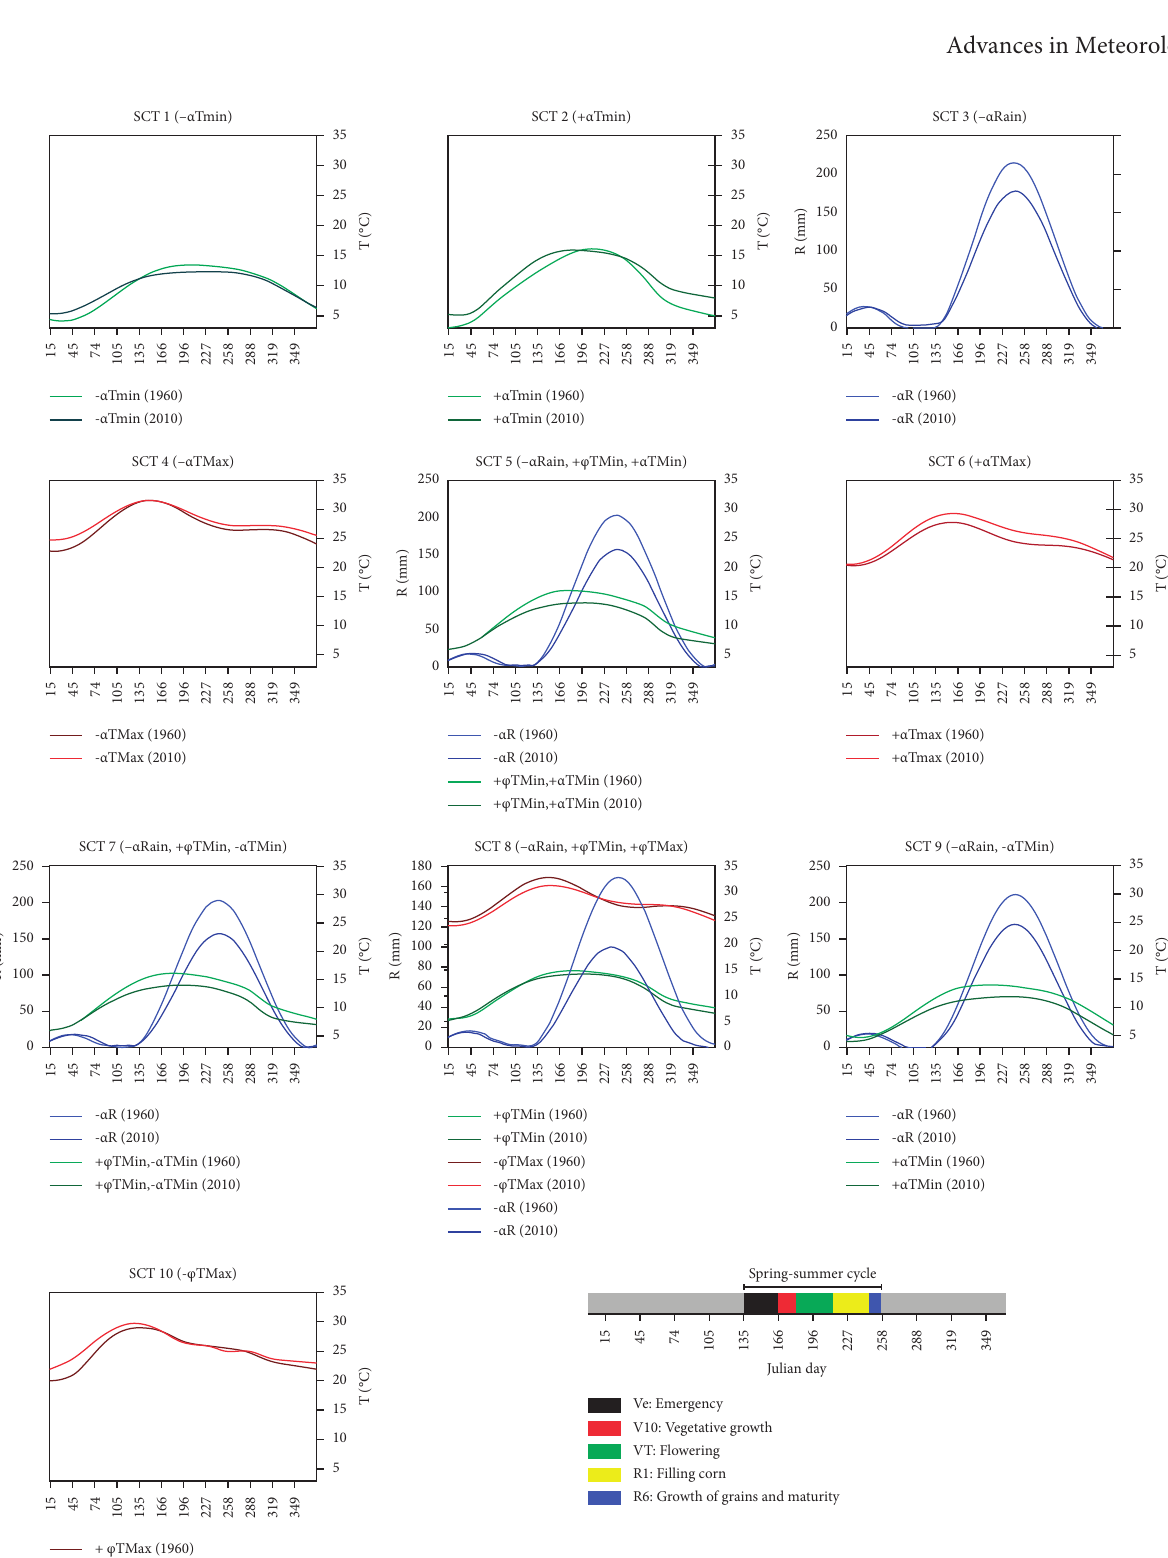
Figure 6: Significant changes in the amplitude and phase of the climatic variables by RCA with respect to the phenological development of the crops for 1960 (1960–1985) and 2010